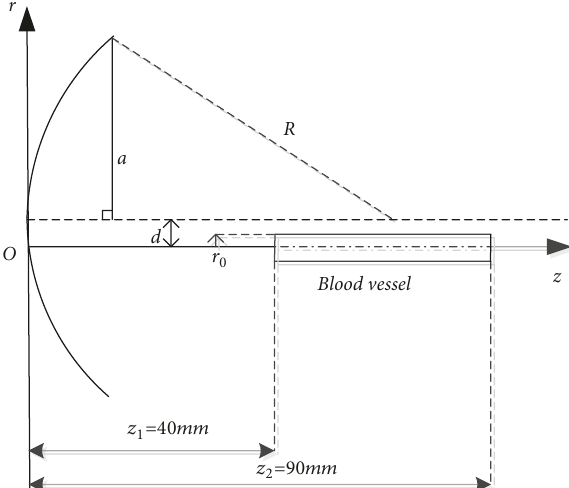
Figure 1: Geometric configuration of physical model. The tissue containing a large blood vessel, a cylinder with radius of 35 mm and length of 50 mm , is placed at 𝑧 1 = 40𝑚𝑚 . The blood vessel is at the center of the tissue, 𝑟 0 is the radius of the blood vessel, and 𝑑 is the distance between ultrasonic focus and central axis of blood vessel. The computational domain Ω is −35𝑚𝑚 ≤ 𝑟 ≤ 35 𝑚𝑚 and 0 ≤ 𝑧 ≤ 90 𝑚𝑚 , abbreviated as 𝑟, 𝑧 ∈ Ω